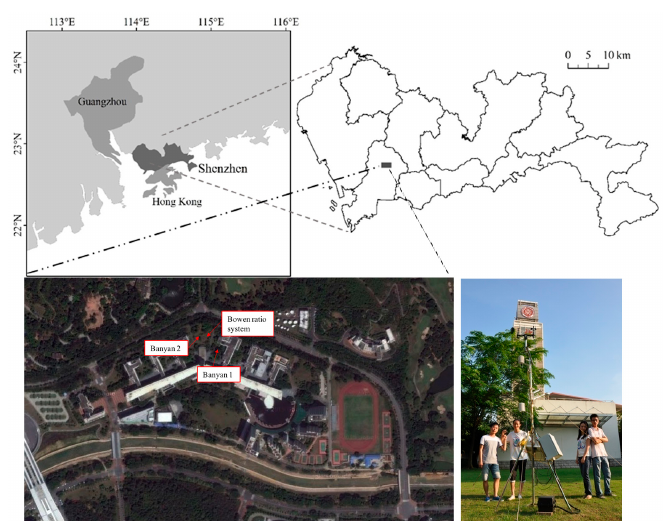
Figure 1. Location of the study area. The upper left figure shows the location of Shenzhen city in China. The upper right figure shows the location of experimental field in Shenzhen. The bottom left figure shows the experimental field and the location of Bowen ratio system (scale = 1:12,500). The photo at bottom right is the Bowen ratio system tower and the lawn field. The experiment was carried out from July 2014 to the end of 2015. The Bowen ratio system was used to measure the meteorological data, including solar radiation, photosynthetic active radiation (PAR), net radiation, the soil heat flux (5 cm under the ground surface, two duplicate samples), the air temperature and humidity at heights of 2 m and 1.5 m. Information regarding the sensor types, measuring height, and sensing resolutions were shown in Table 1. All the data were sampled and recorded at intervals of 1 min and 10 min, respectively, using the Campbell CR1000 data logger. An infrared thermal camera (IR Flexcam Ti55, Fluke Corp., Everett, WA, USA) was used to measure the surface temperature. The measuring wavelength of the infrared thermal imager was 8 ‒ 14 µm, and the resolution was 0.05 °C. Each thermal infrared image contains 76,800 temperature data